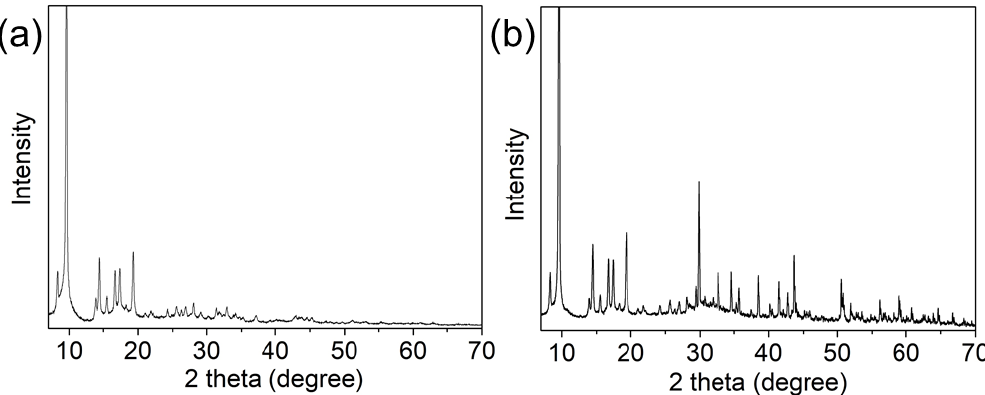
Figure 4. XRD pattern of MIL-68(Ga) ( a ) and magnetic MIL-68(Ga) ( b ).